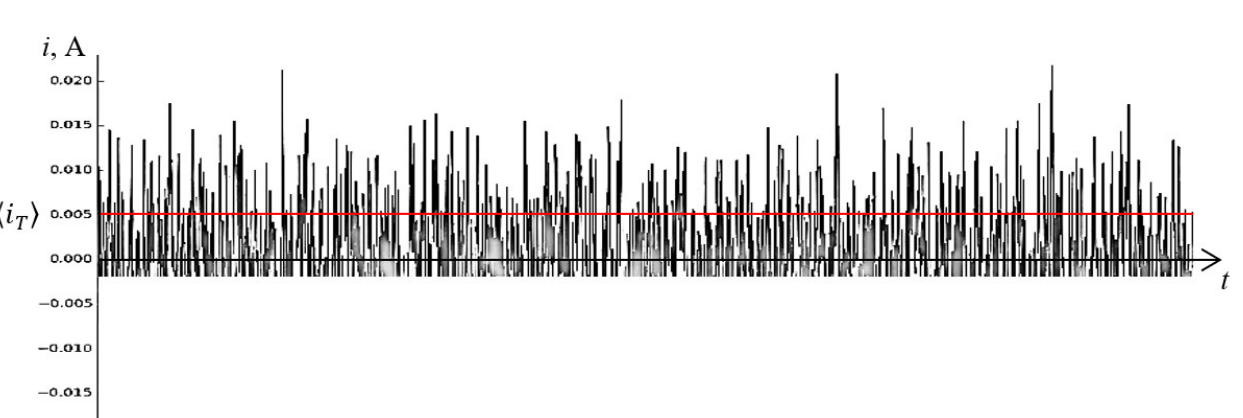
Figure 6. Expected thermal noise in a semiconductor ring.